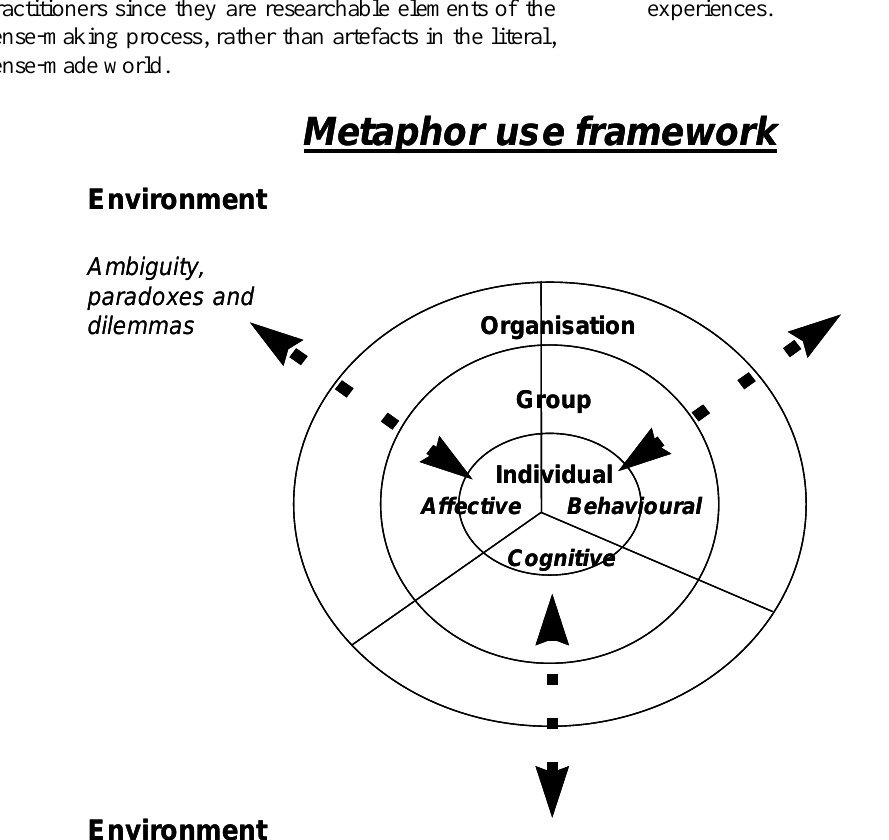
Figure 1: Metaphor use framework Figure 2 illustrates three